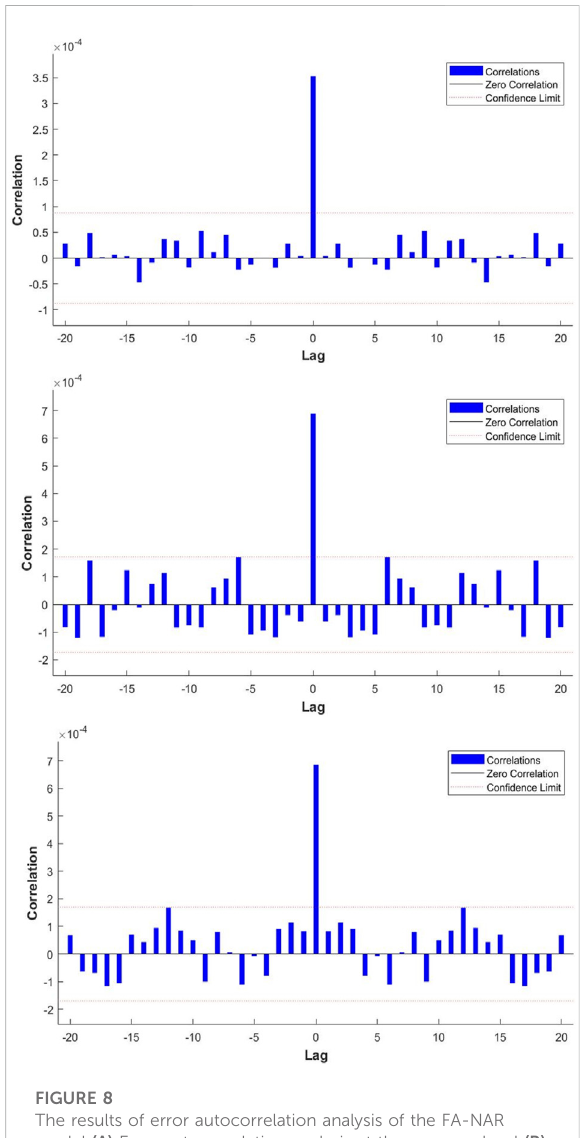
FIGURE 8 The results of error autocorrelation analysis of the FA-NAR model (A) Error autocorrelation analysis at the pressure level (B) Error autocorrelation analysis at the state level (C) Error autocorrelation analysis at the response